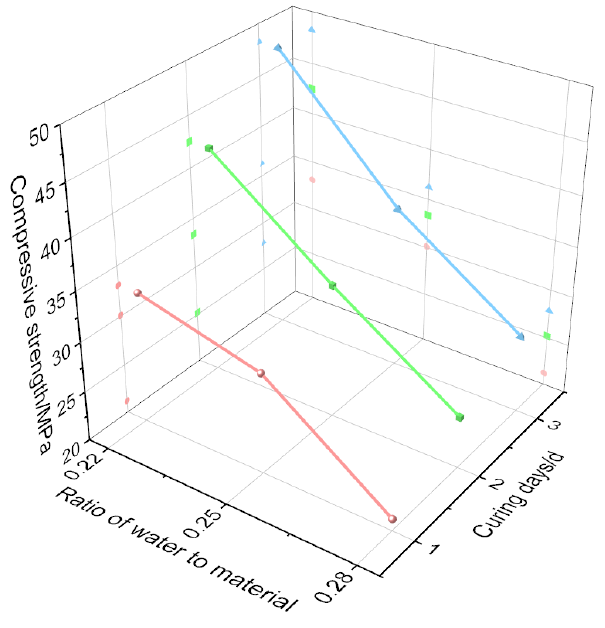
Figure 8. Compressive strength test results.